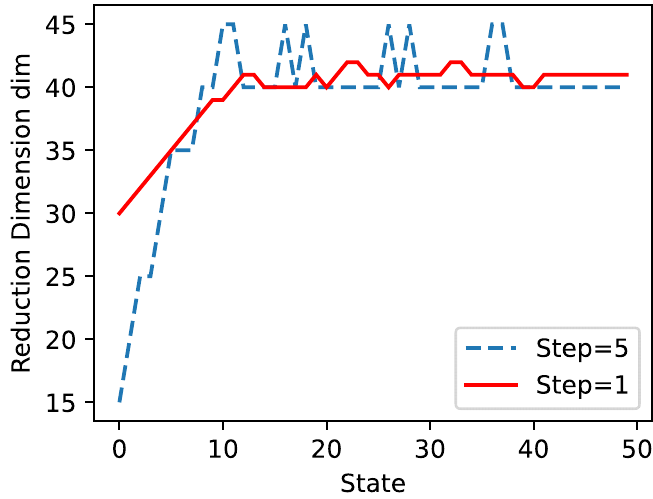
Figure 9. The path of searching for the optimal clustering number dim.